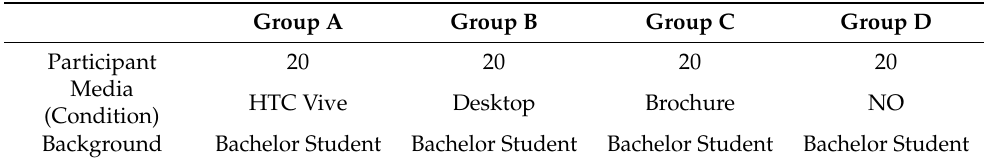
Table 2. Demographics of the